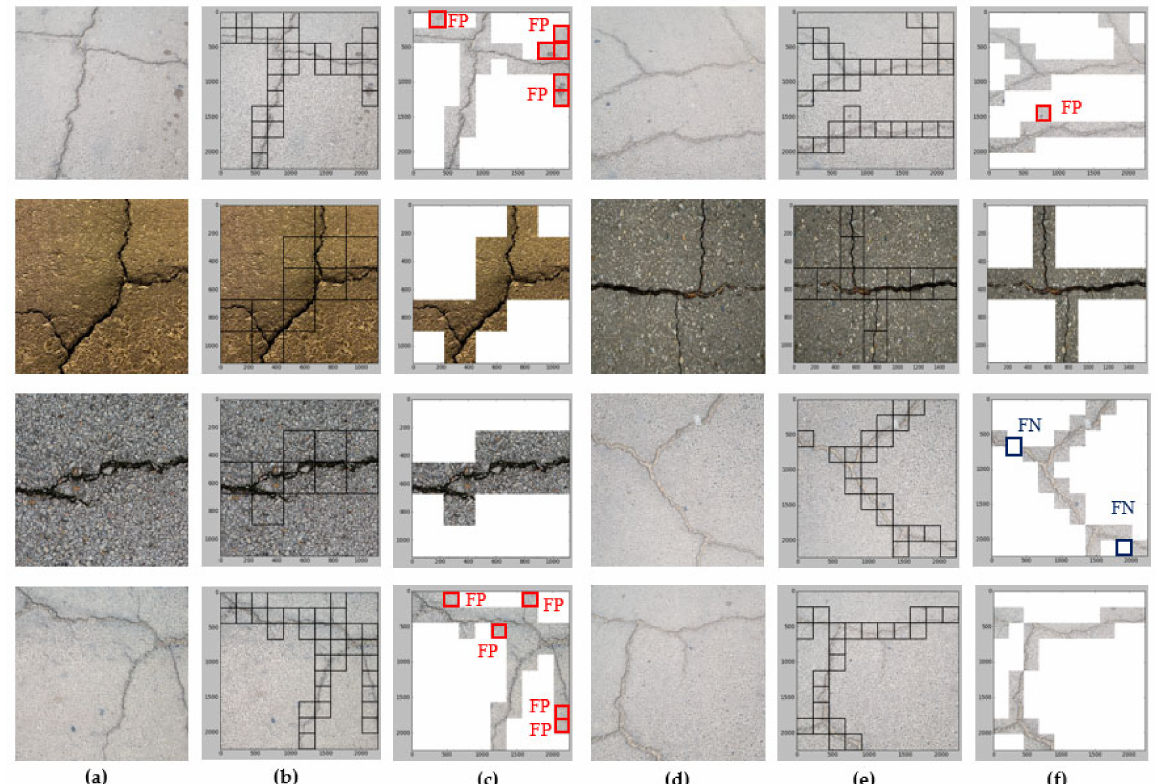
Figure 9. ( a , d ) original images, ( b , e ) crack localization results of the ViT model, ( c , f ) scanning for FP and